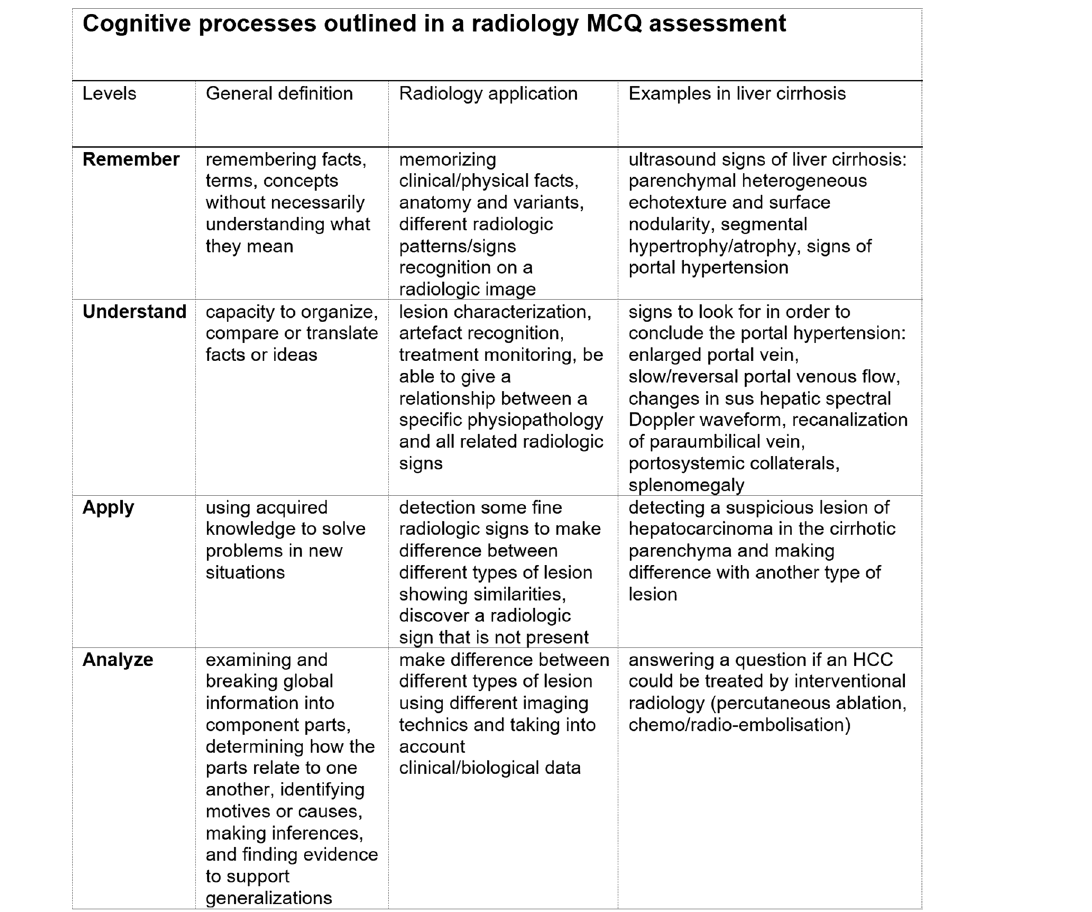
Taxonomy Radiology